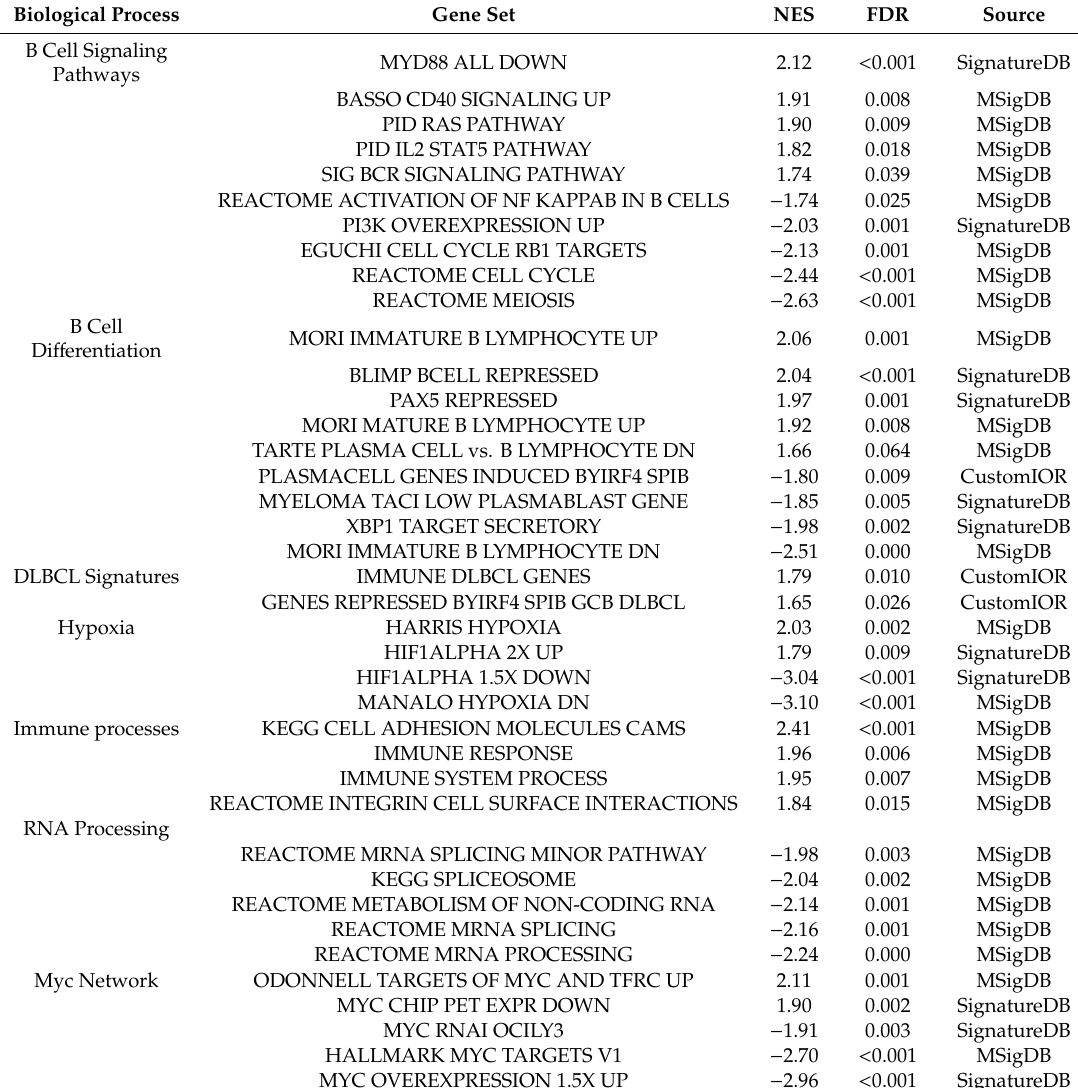
Table 2. Summary of preranked GSEA analysis of RNA-Seq data for ETS1